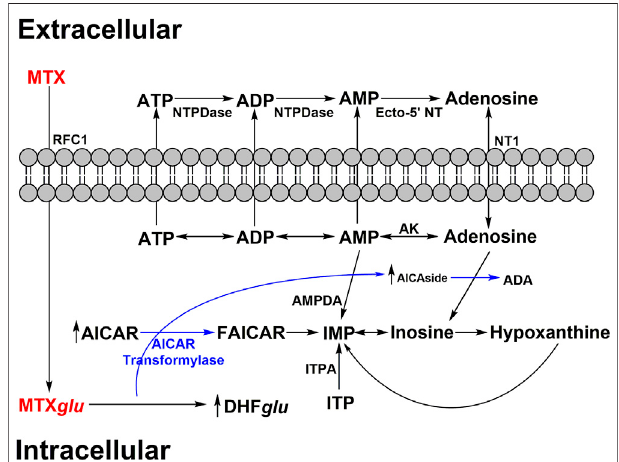
FIGURE 2 | MTX impact on adenosine secretion. MTX is polyglutamylated (MTX glu ) after active transport of MXT into intracellular space. MTX glu inhibits AMP/adenosine deaminase (AMPDA/ADA respectively) and thus IMP/inosine production through accumulation of aminoimidazole carboxamidoribonucleotide (AICAR) and aminoimidazole carboxamidoribonucleoside (AICAside), the intermediate metabolites of purine biosynthesis. This results in increased cellular release of adenine nucleotides which are quickly converted into adenosine in the extracellular space. Adenosine triphosphate – ATP; adenosine diphosphate – ADP; adenosine monophosphate – AMP; adenylate deaminase – AMPDA; dihydrofolate polyglutamate - DHF glu ; formyl AICAR - FAICAR; Inosine monophosphate – IMP; inosine triphosphate – ITP; inosine triphosphate pyrophosphatase – ITPA; reverse folate carrier 1 – RFC1; adenosine kinase – AK; nucleoside triphosphate phosphohydrolase – NTPDase; ecto-5 ’ nucleotidase – Ecto-5 ’